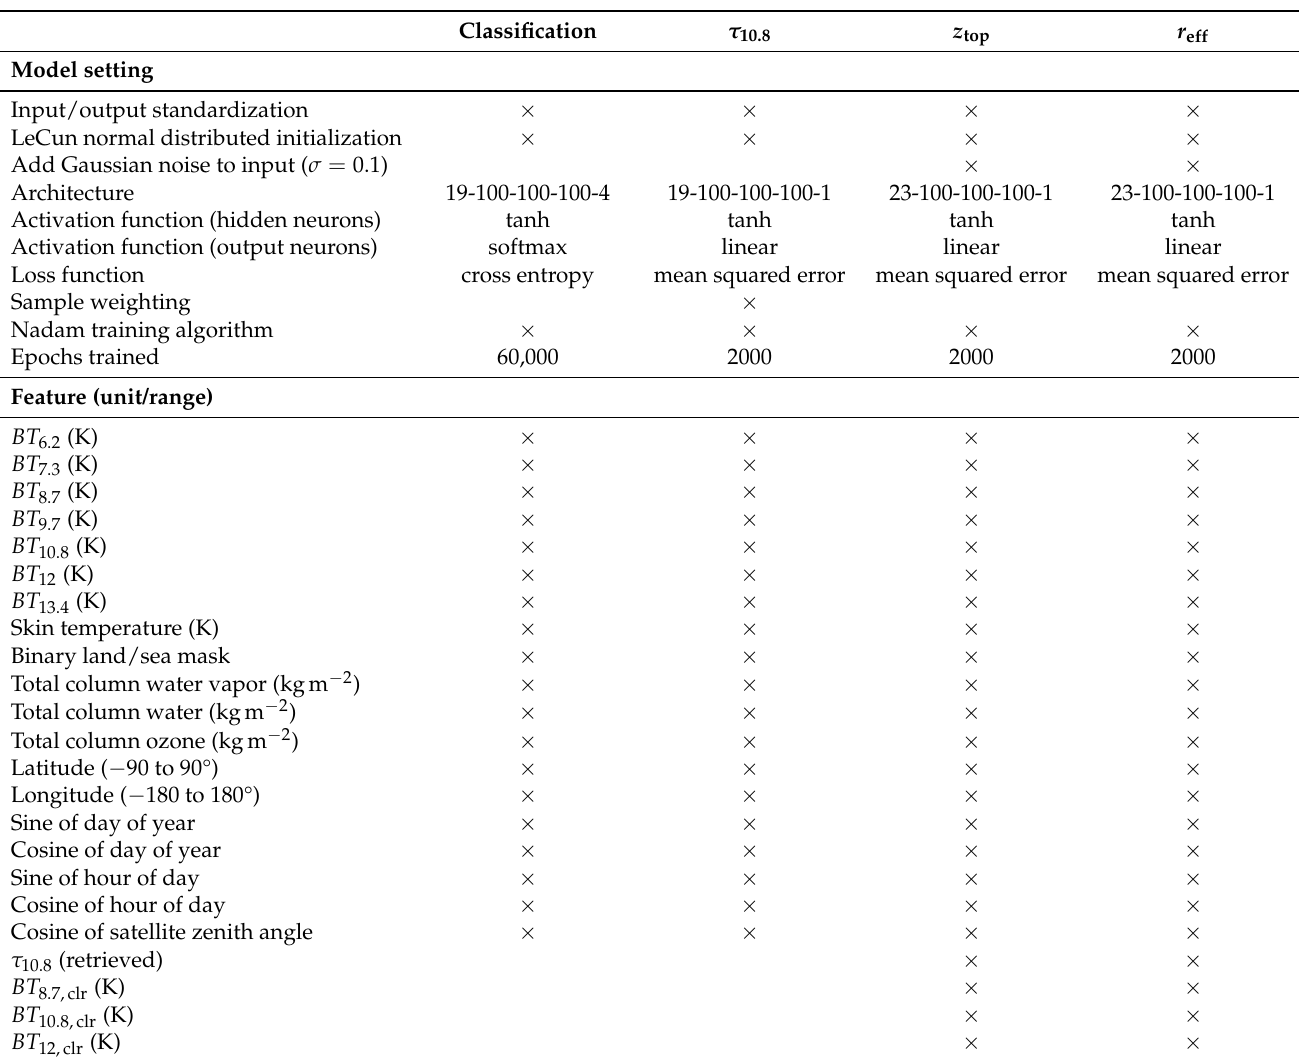
Table 2. Model settings and input features for the ANNs retrieving the classification, τ 10.8 , z top and r eff . σ denotes the standard deviation. The ANN architectures are given as lists of neurons per layer, with the first number giving the amount of input neurons, the second number the amount of neurons in the first hidden layer and the last number the amount of output